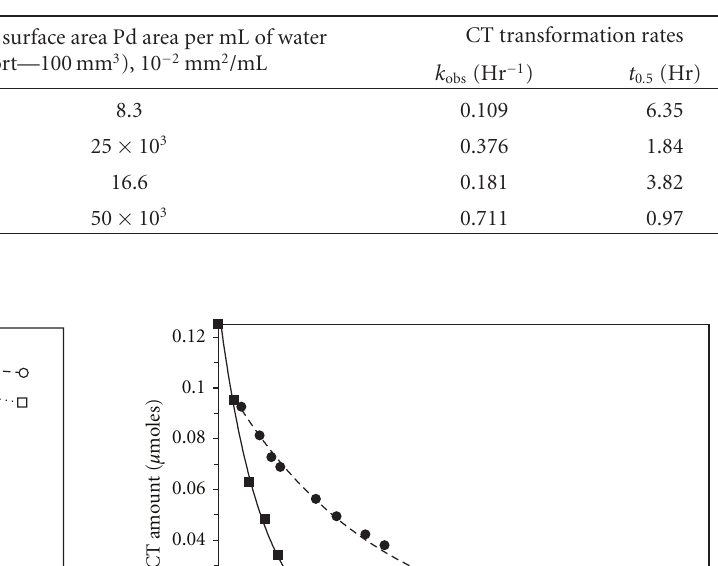
Table 1: Estimated surface area of Palladium nanoparticles on di ff erent supports and values of rate constants for reduction and half-life of CT ( k obs , t 0 . 5 ) at [pH 2 ] 0.05 atm.